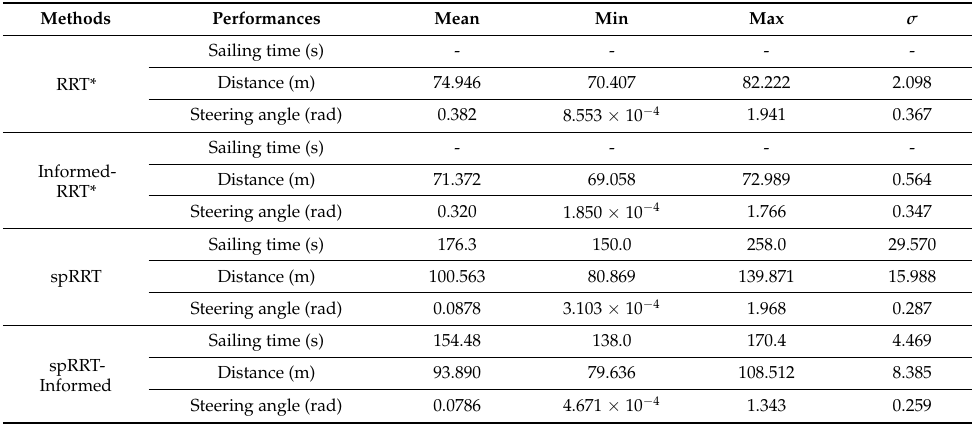
Table 3. Path characteristics parameters under scenario